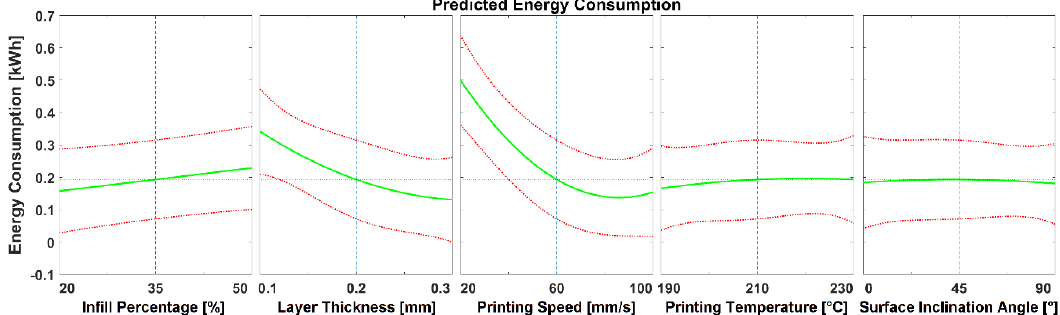
Figure 13. Predicted effects of changes in process parameters on energy consumption.